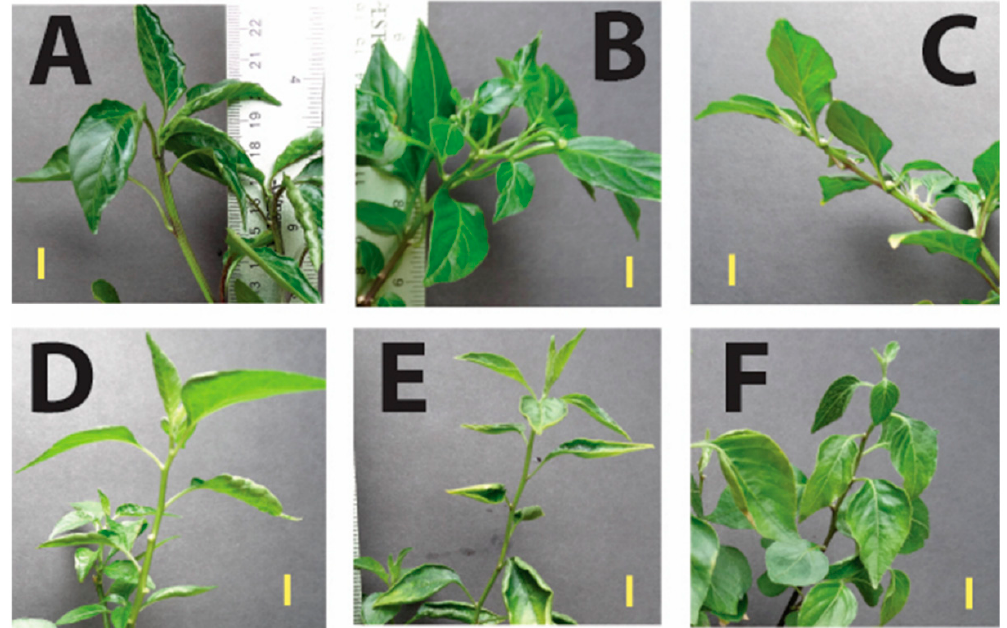
Figure 3. Variation of stem thickness for Capsicum spp. evaluated in this study: C. annuum ( A ), C. baccatum ( B ), C. chinense ( C ), C. frutescens ( D ), C. eximium strain CGN 19198 ( E ), and C. eximium strain CGN 24332 ( F ). Yellow scale bar = 1 cm.